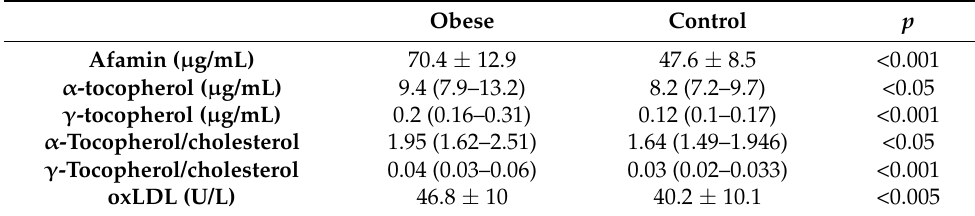
Table 3. Afamin, α - and γ tocopherol levels and oxidized LDL in obese patients and controls. Obese